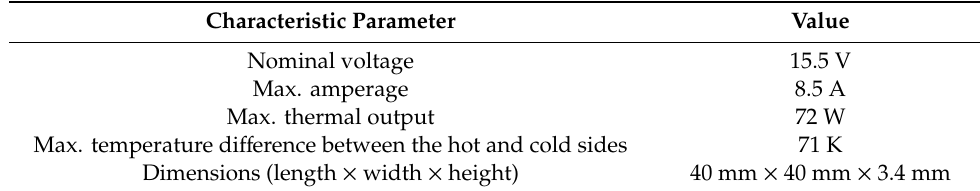
Table 2. Applied TE module technical characteristics.